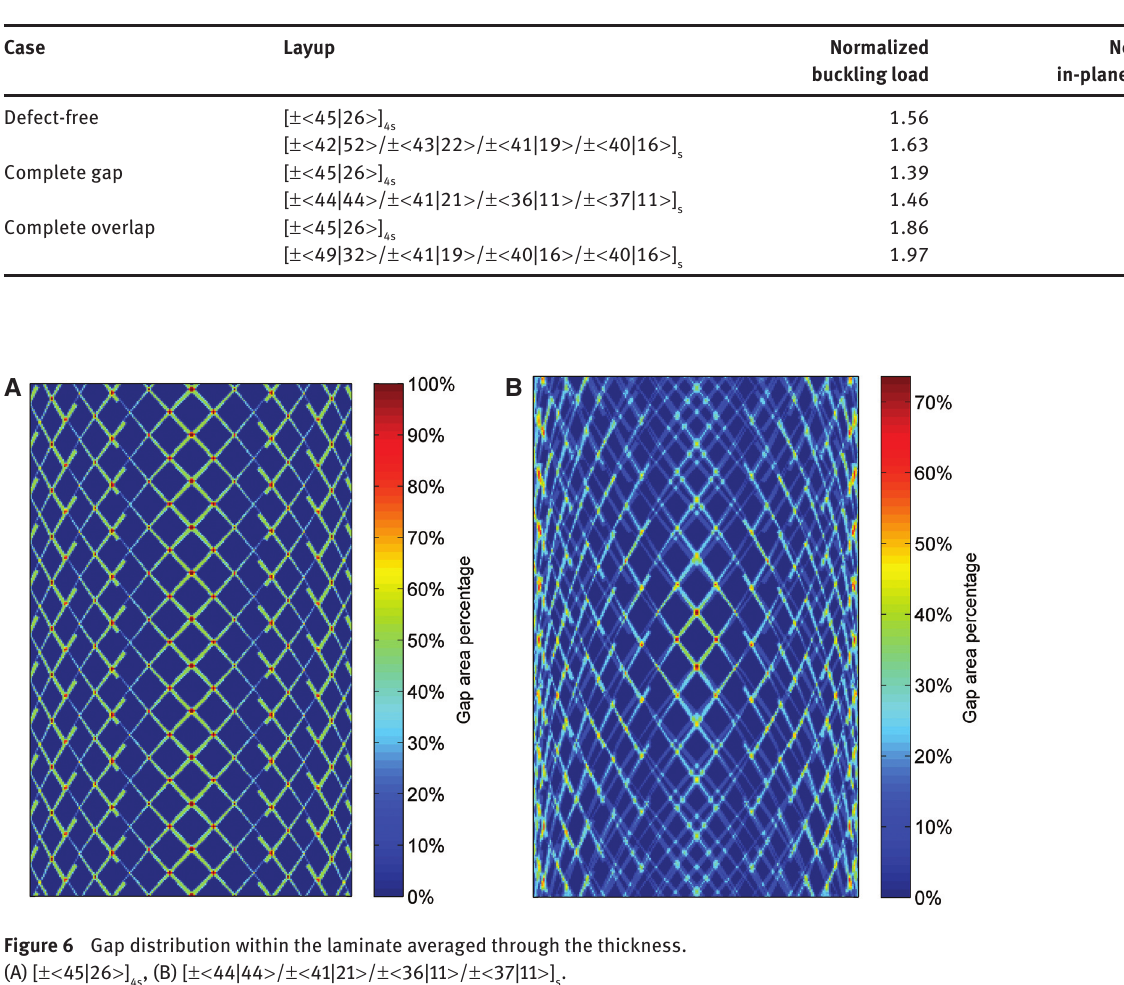
Table 1 Structural properties of designs with the highest buckling load with [ ± θ ( x )] with respect to the baseline.